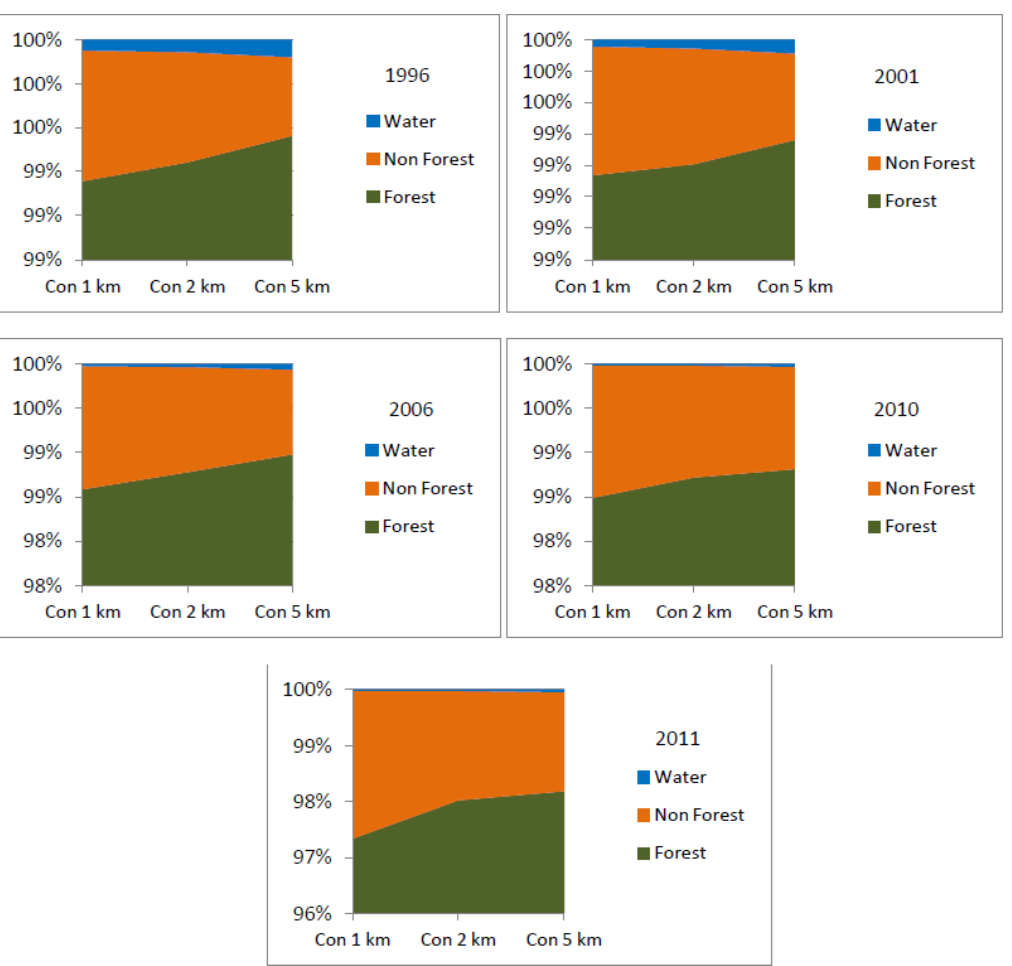
Figure 7. Forest, non-forest and water land-cover change dynamic of 1 km, 2 km, and 5 km road buffer within timber concession areas for 1996, 2001, 2006, 2011 for the Province of